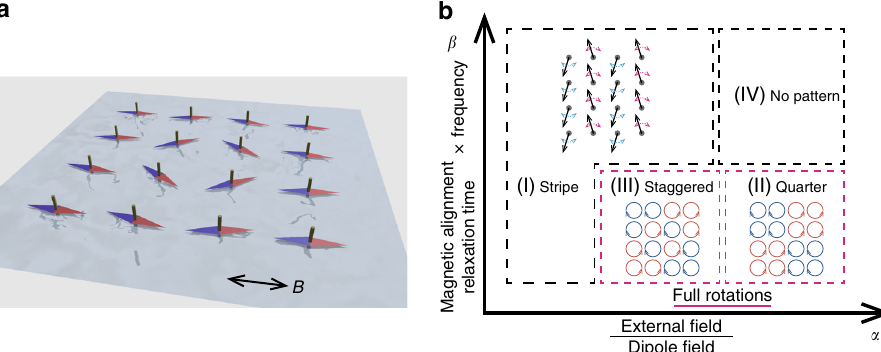
Fig. 1 System set-up and summary of dynamical responses. a Schematic of the system set-up. b Phase diagram of the reported three collective phases as follows (see Fig. 4c for a full-phase diagram). I Stripe pattern: when the magnetic dipole interaction is dominant, the rotors swing upwards or downwards in alternating stripes. II Quarter pattern: when the external fi eld dominates over the dipolar interactions, the rotors undergo full rotations, with different quadrants of the array turning in different directions. III Staggered pattern: when the dipole interactions and the external fi eld are comparable, the rotors show full rotations with the rotational direction forming a staggered